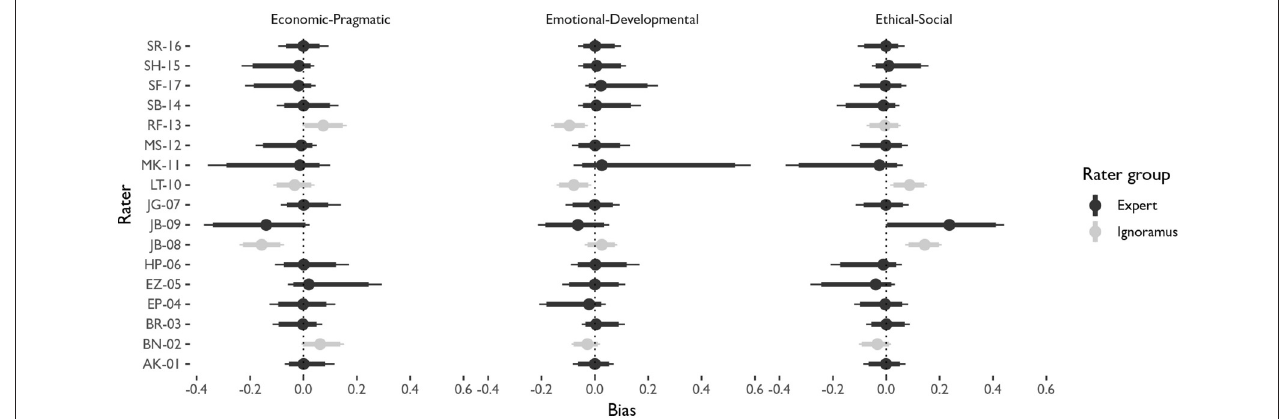
FIGURE 5 | Caterpillar plot showing the mean (dot) and credible intervals (90 and 95 percent with thick and thin lines, respectively) of the posterior densities of ω . The dots represent the point estimate expected value of the rater bias for that specific case and axis of values in the latent configuration of values. The lines represent the credible intervals at standard margins of uncertainty.